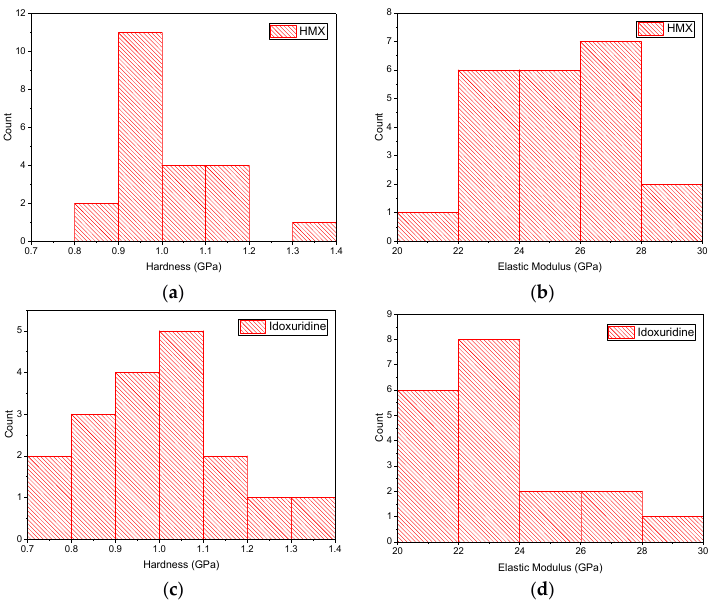
Figure 2. ( a ) HMX hardness measurement distribution. ( b ) HMX reduced elastic modulus measurement distribution. ( c ) Idoxuridine hardness measurement distribution. ( d ) Idoxuridine reduced elastic modulus measurement distribution.